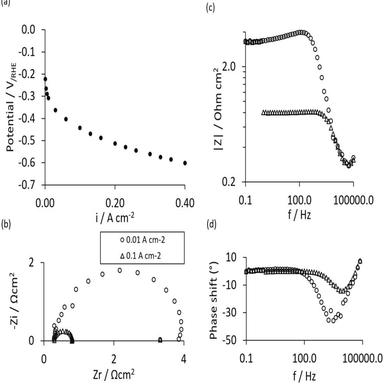
A) HER polarization curve of a nickel plate electrode in a three electrode laboratory setup operating with 6 M KOH at room temperature; b) Nyquist plots for 0.01 and 0.1 A cm− 2 ; c) and d) Bode plots showing the dependence of absolute impedance and phase shift on the frequency for 0.01 and 0.1 A cm− 2 . Description of the three electrode beaker type laboratory setup can be found in.